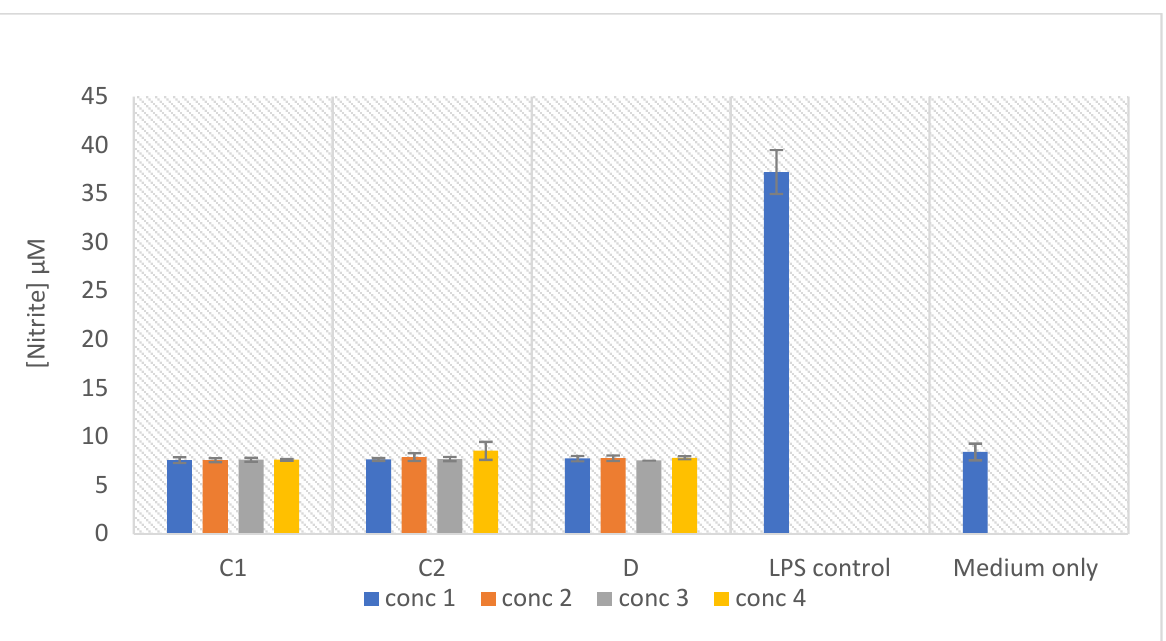
Figure 11. Nitric oxide production in the macrophages treated with different concentrations of the samples, as indicated in Section 2.2. Concentrations tested were as follows: Sample C1 (methanol extract): 5, 10, 20, and 40 μ g/mL; Sample C2 (chloroform extract): 1.25, 2.5, 5, and 10 μ g/mL. Bar graph represents the quadruplicate values of one experiment. Error bars represent the standard deviation of the mean.